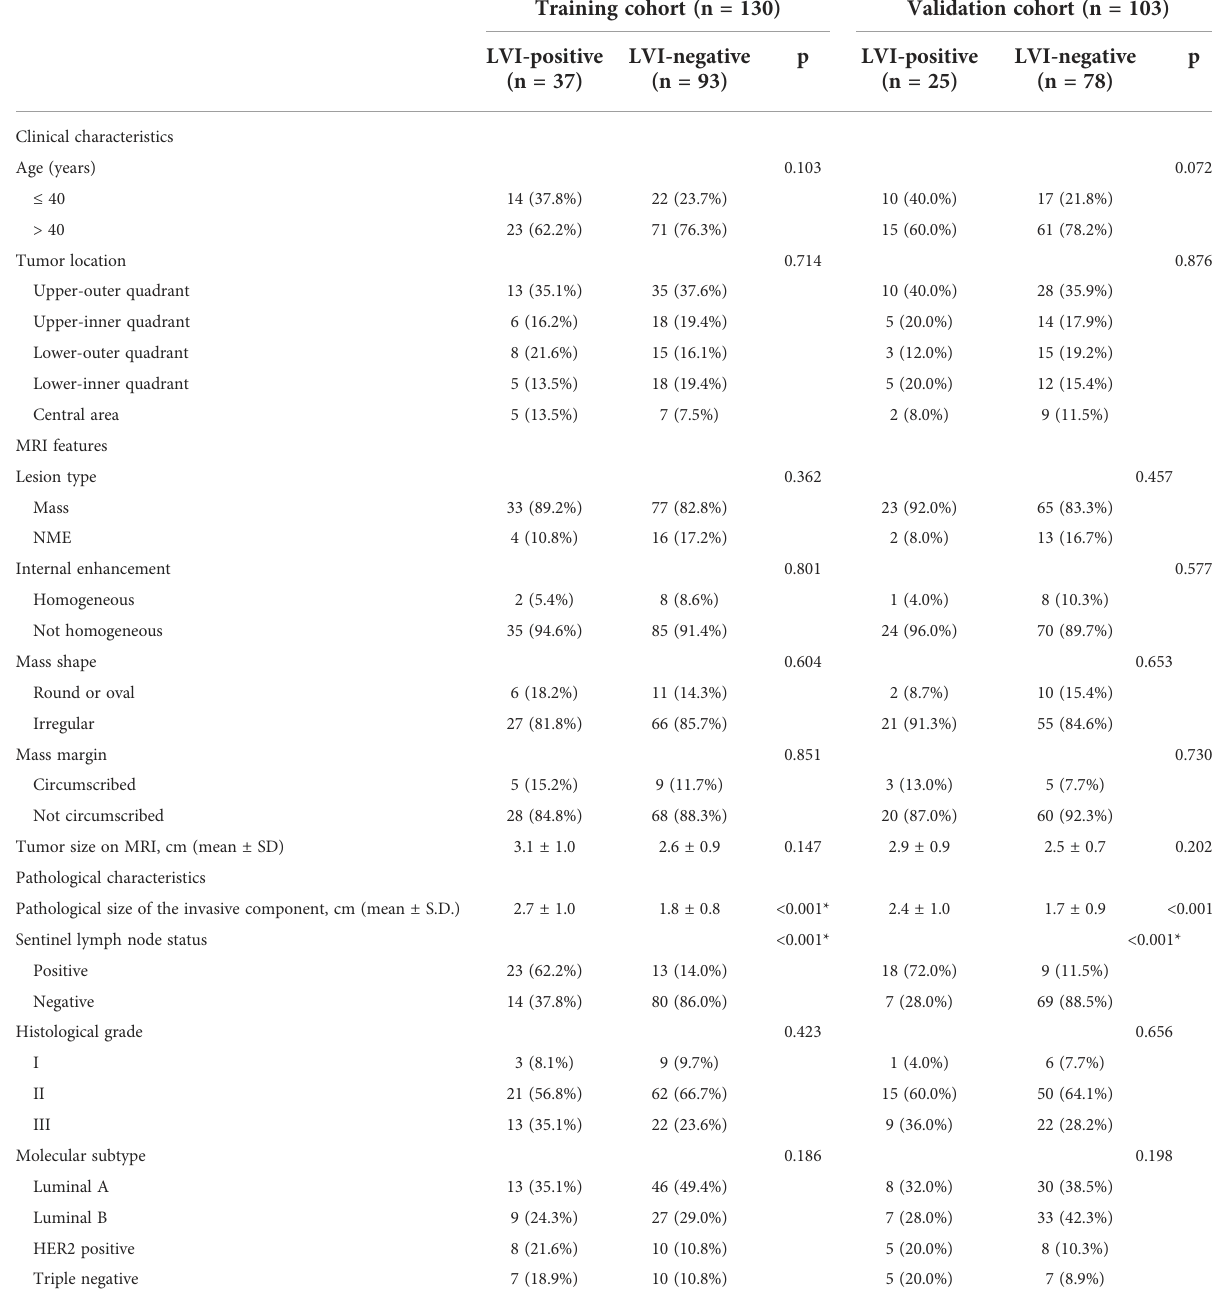
TABLE 1 Clinicopathologic